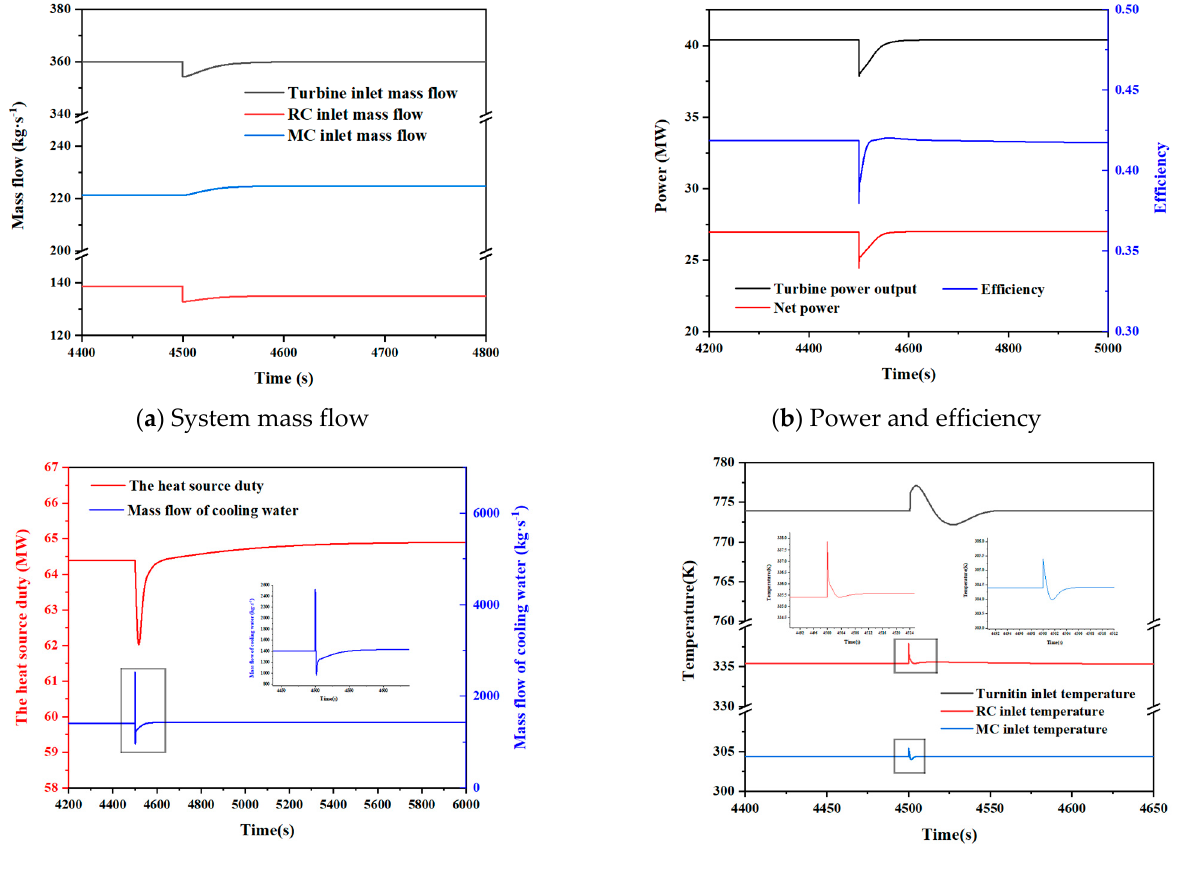
Figure 11. Response curves of controlled parameter with SR disturbance.